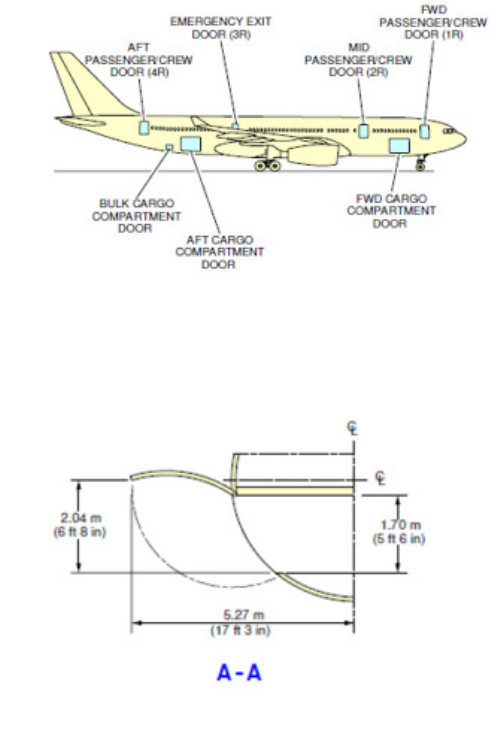
Figure 3. Airbus A330–200 cargo door position and dimensions [50].